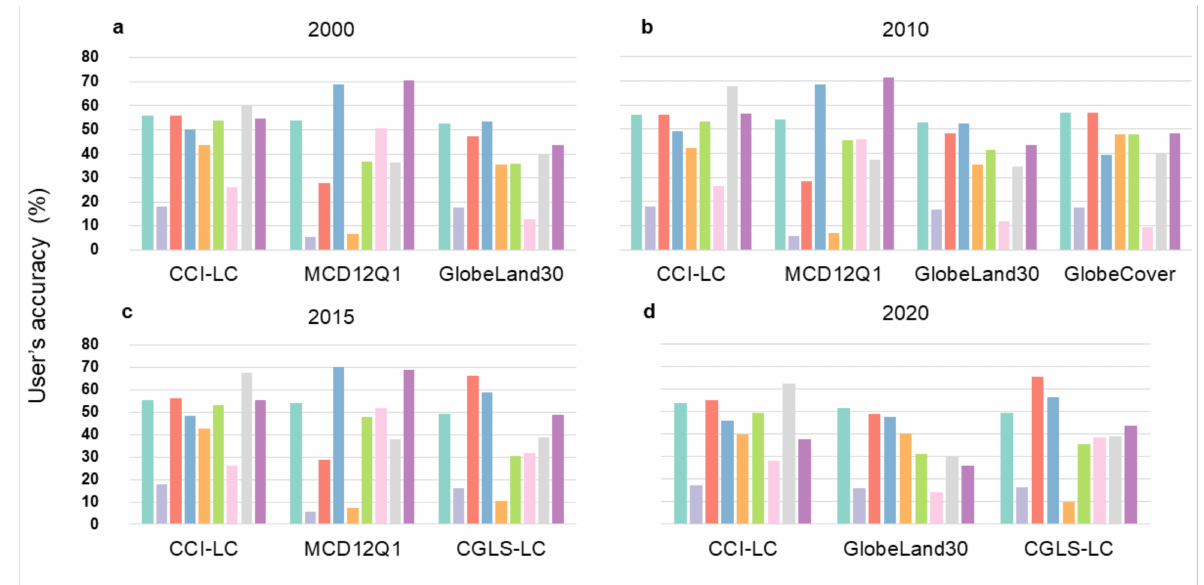
Figure 8. User’s accuracy for various LC datasets in epochs ( a ) 2000, ( b ) 2010, ( c ) 2015, and ( d )